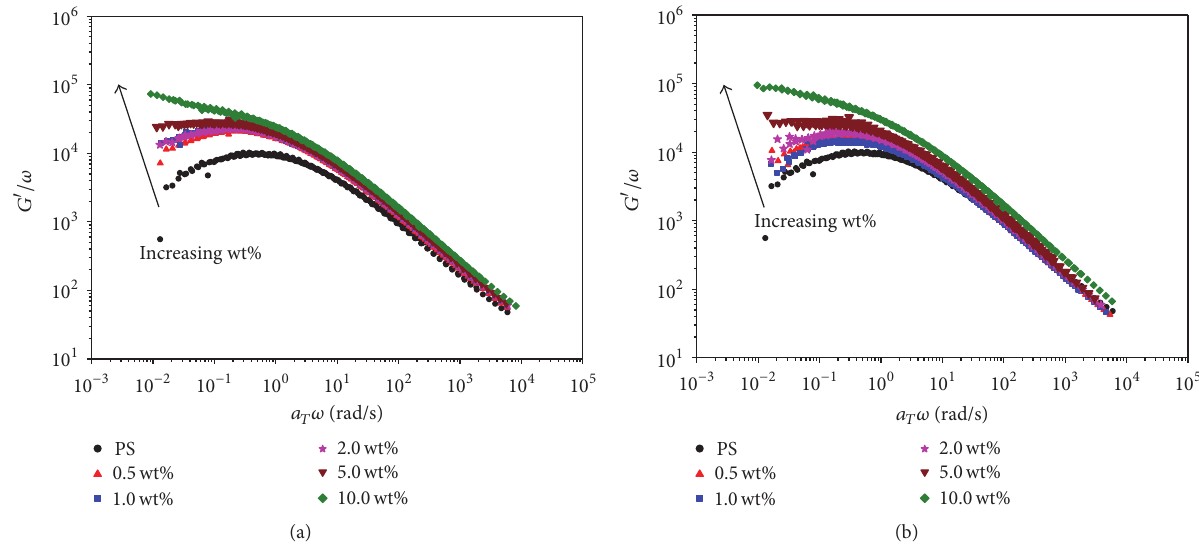
Figure 3: 𝐺 󸀠 /𝜔 versus angular frequencies was plotted using master curve. (a) Nanofiber/PS blend and (b) nanosheet/PS blend in terms of nanofiller loading.